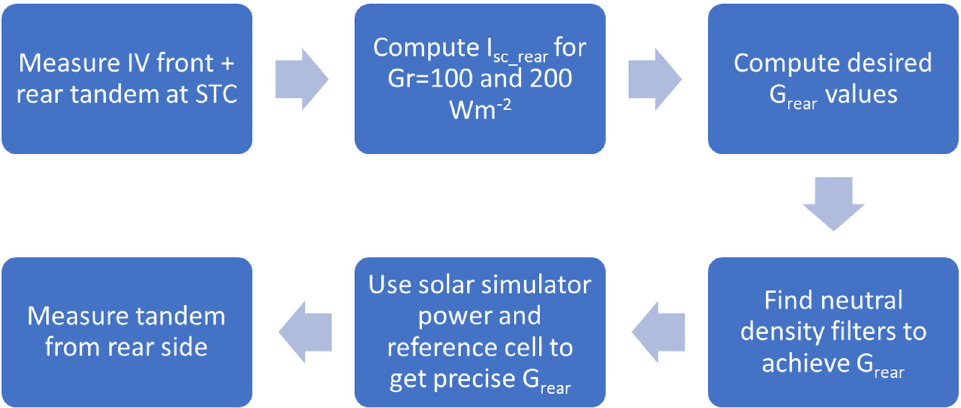
Fig. 5. Flow chart of adapted protocol as proposed in